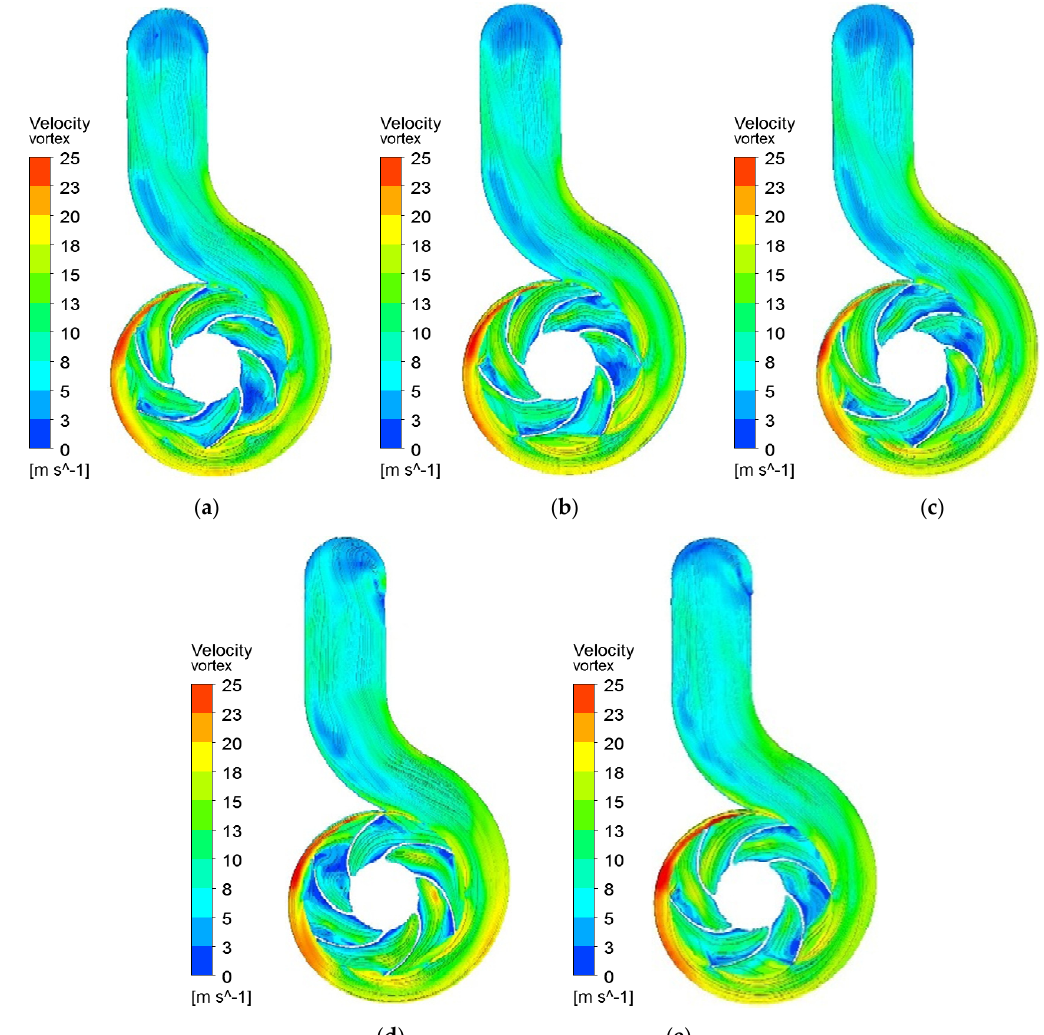
Figure 16. Velocity vortex distribution under Q r : ( a ) t = t 0 ; ( b ) t = t 0 + 1 / 2T; ( c ) t = t 0 + T; ( d ) t = t 0 + 3T; ( e ) t = t 0 + 5.5T.